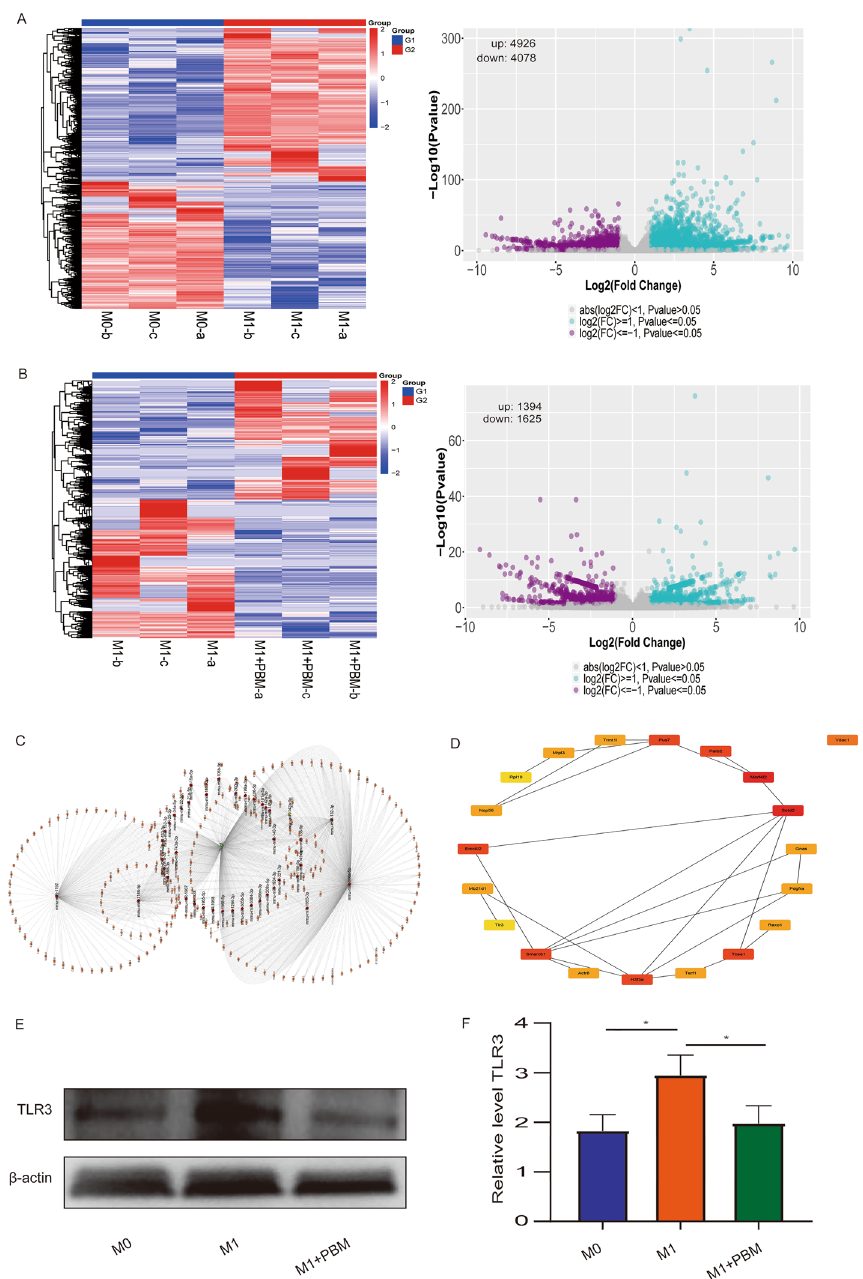
Fig. 4 Construction of lncRNA TUG1-miRNA-mRNA network. A Differentially expressed mRNAs in M0 group versus M1 group were presented as heat map and volcano map. B Differentially expressed mRNAs in M1 group versus M1 PBM group were presented as heat map and volcano map. C Bioinformatics analysis of + potential TUG1-miRNA-mRNA networks with TUG1 as the core. D The Cytoscape software analysis hub-gene is presented (TOP20). E The expression of TLR3 detected by western blotting was consistent with the sequencing results. n 3 per group. **** P < =